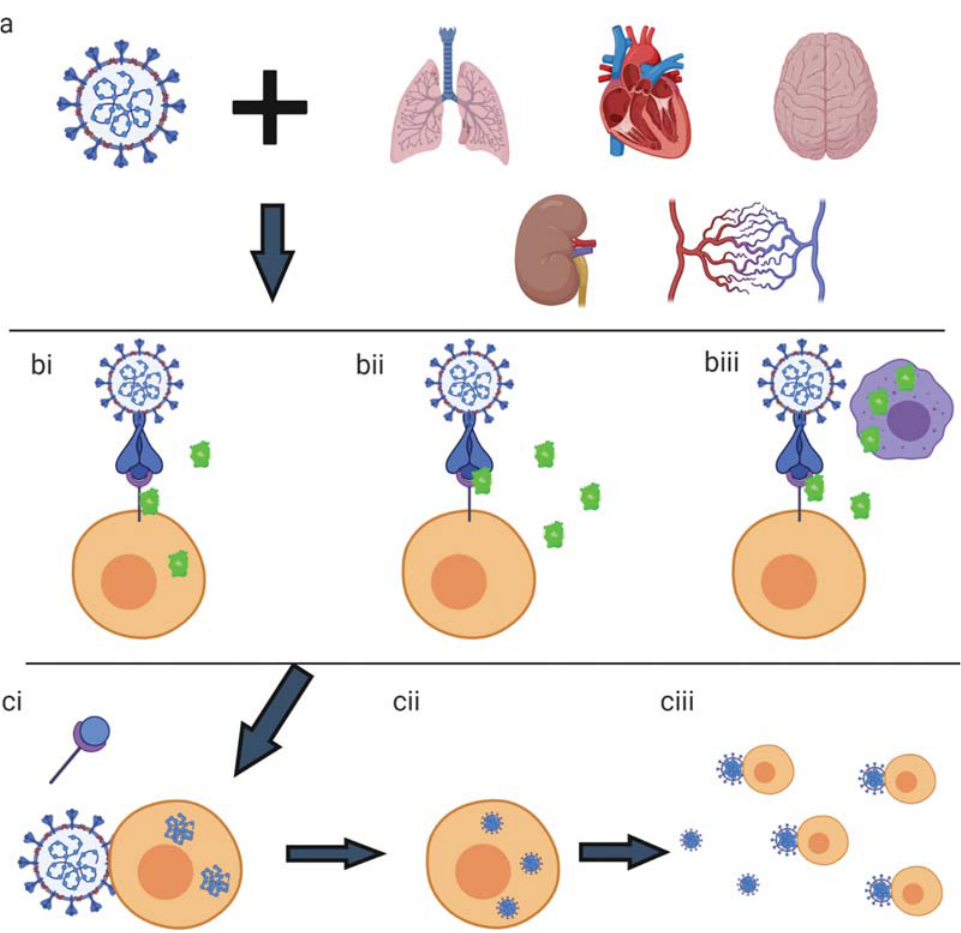
Fig. 1 The potential role of factor Xa in Co-Vcellular infection. Top: The coronavirus (left) binds to multiple cells that express receptors that bind to the coronavirus spike protein (a). For example, the spike protein can bind to ACE2 receptors, which are present in the alveolar and bronchiolar epithelium, cardiac myocytes, the brain/central nervous system, the kidneys (primarily the proximal tubules), and the vascular endothelium. Middle: Once the spike protein is bound to the host cell receptor, a proteolytic enzyme binds to the spike protein to cleave the protein into spike protein 1 and spike protein 2. In this example, the proteolyticenzyme is serine protease, factor Xa. (bi) Factor X and factor Xa can be expressed by the host cell directly, allowing for colocalization of the spike protein receptor and the serine protease. (bii) Factor Xa can be present, unbound in the circulation. (biii) Factor X and factor Xa can be localized to the spike protein by nearby cells expressing factor X and factor Xa, such as macrophages. Bottom: Once the spike protein is successfully cleaved by the proteolytic enzyme, spike protein 1 is released with or without the bound host cell receptor, while spike protein 2 aids in the fusion of the viral and host cell membrane. (ci) The virus and host cell membrane are fused and the viral genetic material is inserted into the host cell. (cii) The viral genetic material replicates within the host cell. (ciii) New coronavirus viral particles are released by the host cell, resulting in infection of new host cells as well as propagation of in fl ammation and